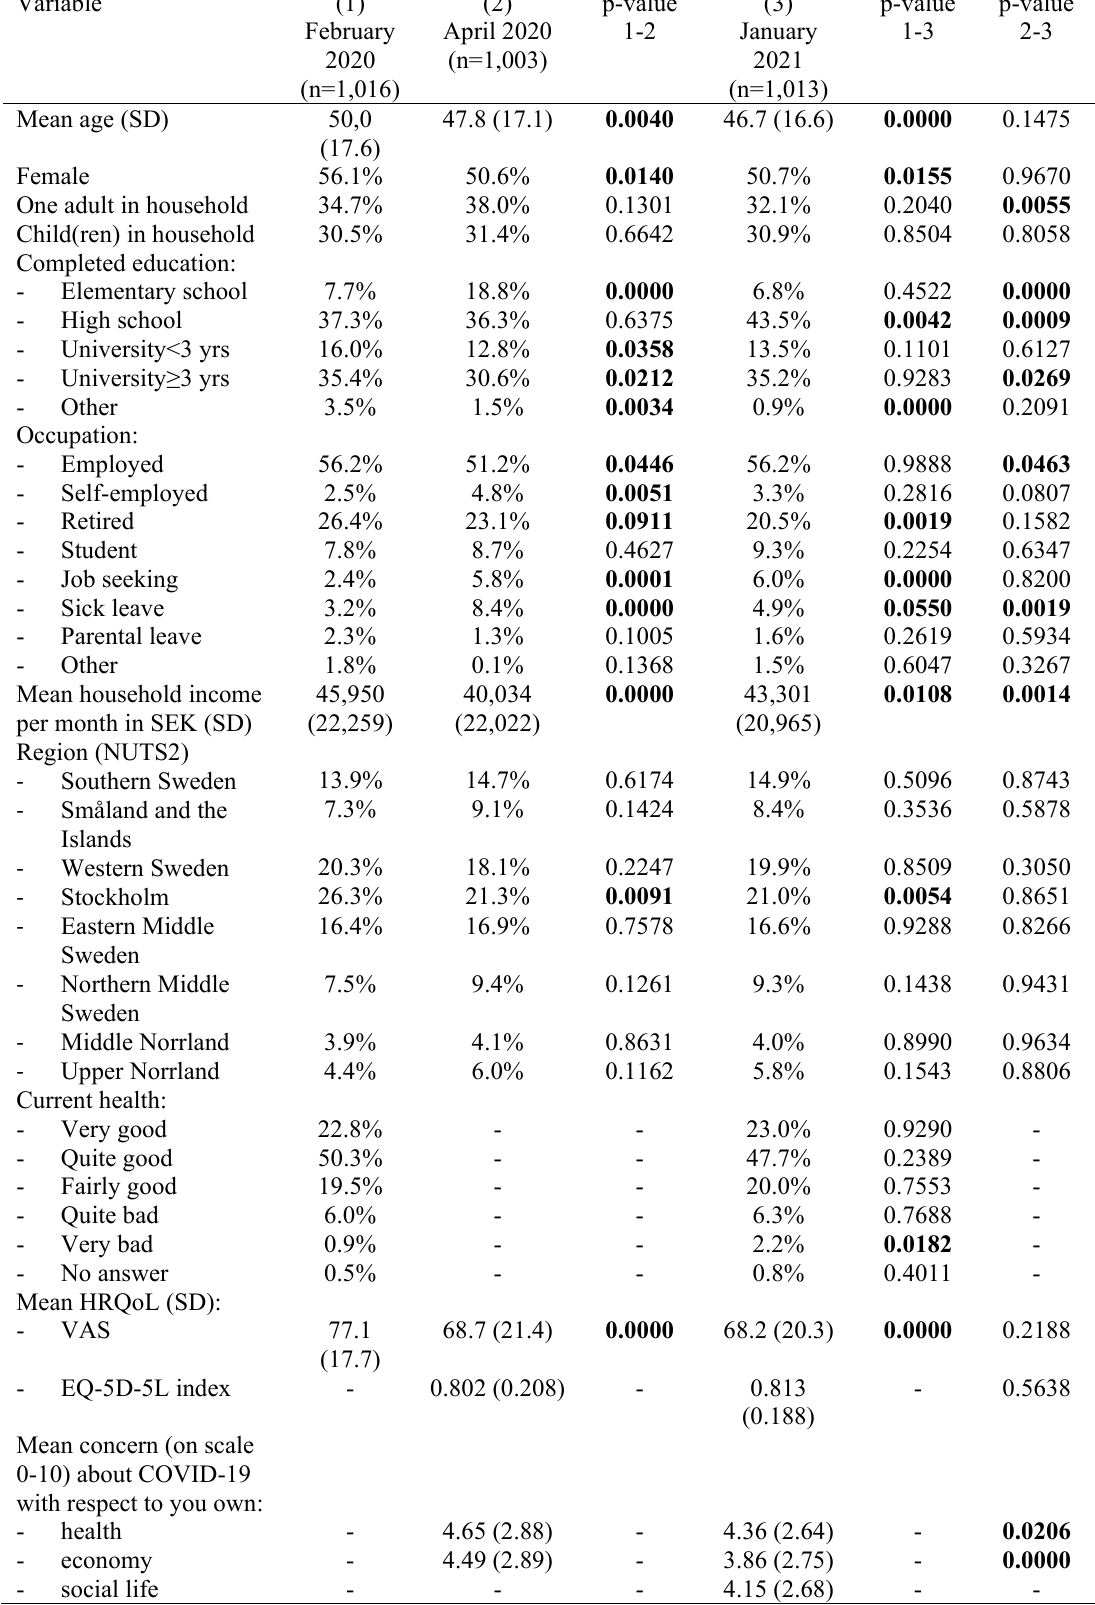
Bold figures refer to statistically significant differences across